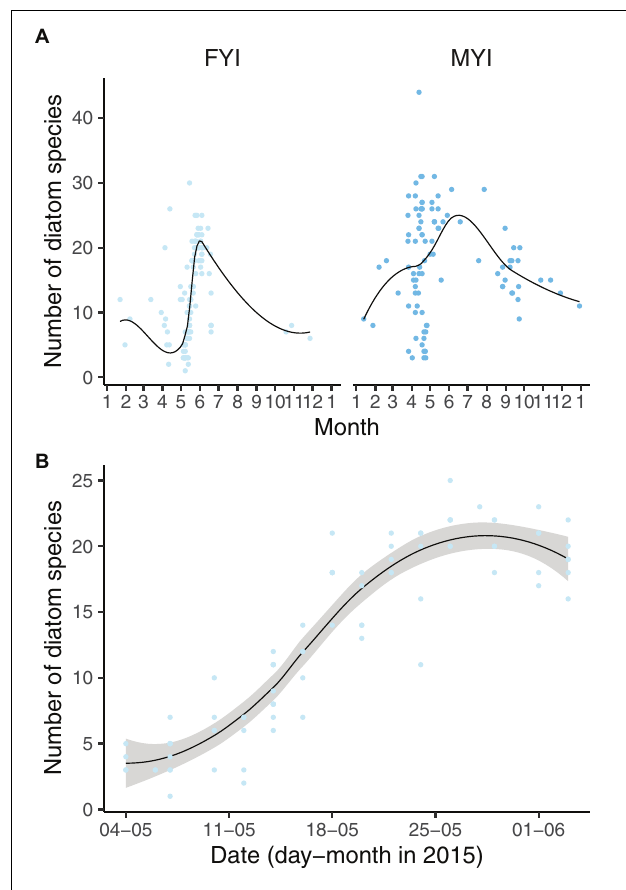
FIGURE 4 | Diatom diversity in first-year ice (FYI) and multiyear ice (MYI) (A) as well as N-ICE samples (B) related to day of the year. B Includes data for thin ( < 30 cm) newly formed ice North of Svalbard. See Figure 3 for further explanation of symbols and lines.